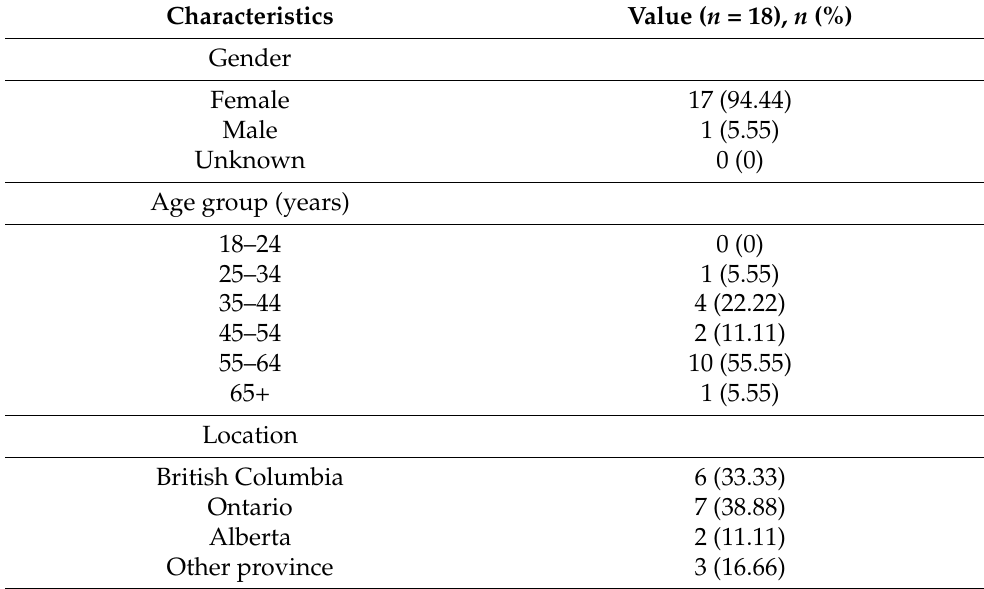
Table 1. Demographic information of participants ( n = 18). Includes data related to gender, age, location, type of cancer, and treatment